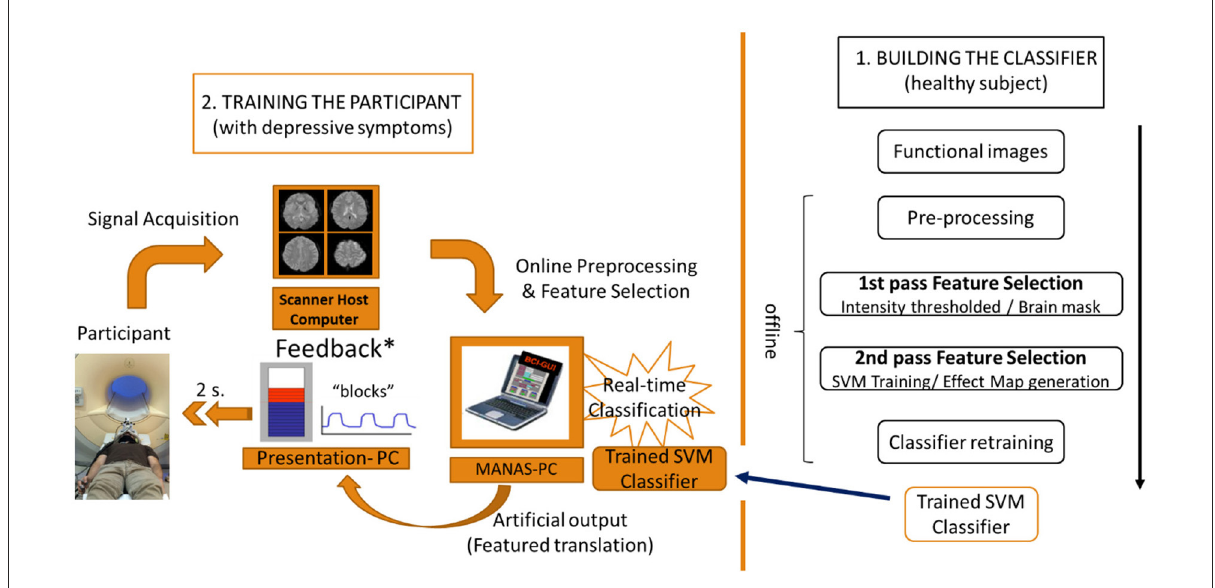
FIGURE1 Flow chart of the 2-step experimental protocol. 1. Building the classifier with the neural information (BOLD signal) of the healthy subject. 2. Training of the participant with depressive symptoms using an rt-fMRI NF system based on the